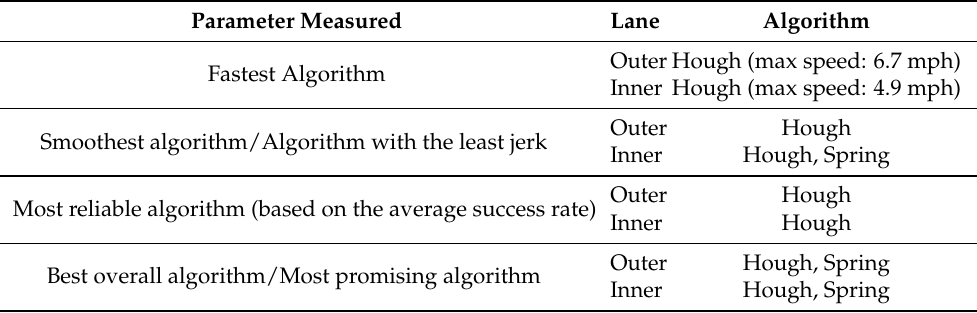
Table 5. Summary of the findings. Parameter